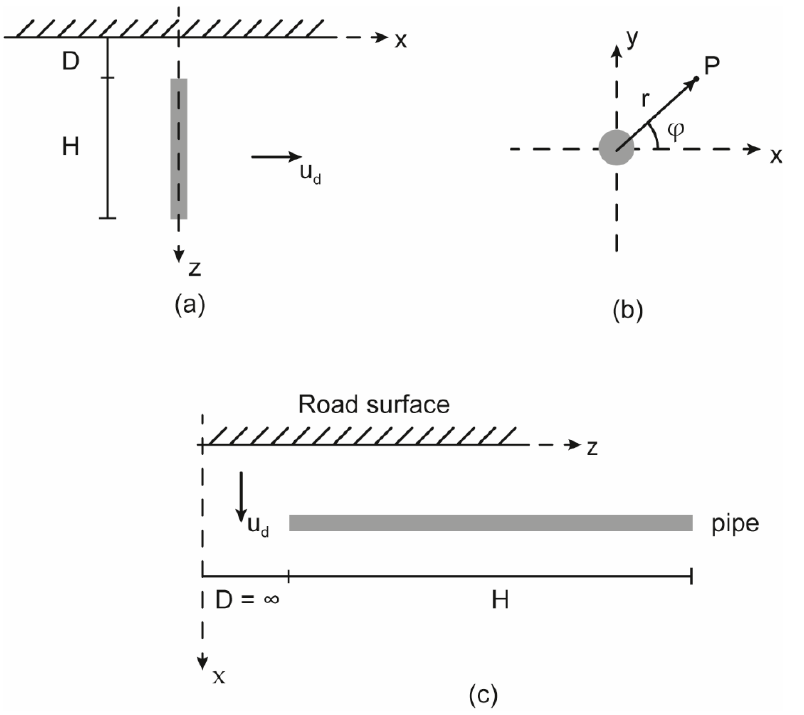
Figure 4. ( a ) Side view of a buried BHE in the model proposed in [27]. ( b ) Top view of the buried BHE. The finite line source model is used to calculate the temperature at a distance r from the borehole. ( c ) In the present case we adapt the model to describe a horizontal pipe section buried in the roadbed. The temperature averaged over the length of the source